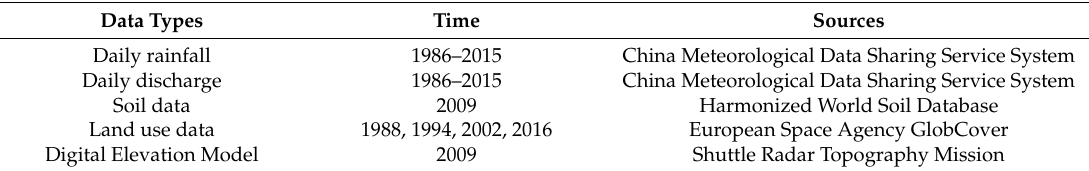
Table 1. The data used in this